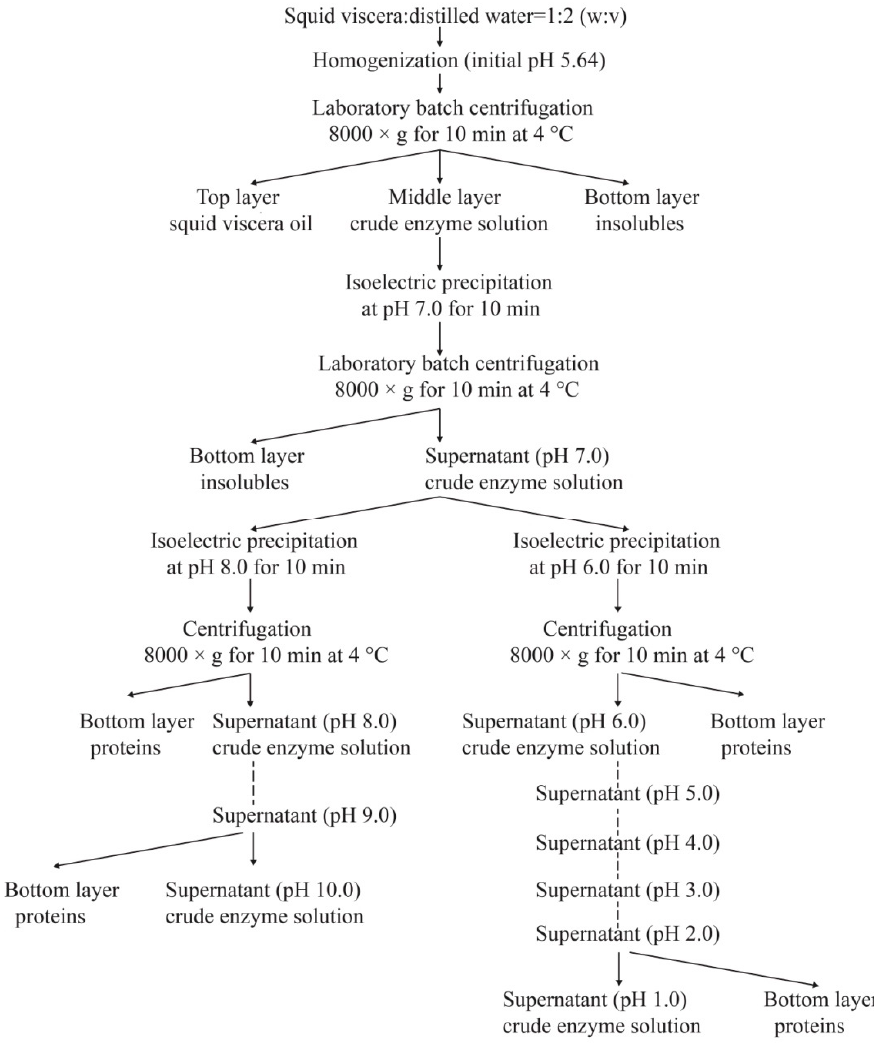
Figure 1. Schematic illustration of the procedures for extraction of proteases from neon flying squid viscera using isoelectric solubilization/precipitation.